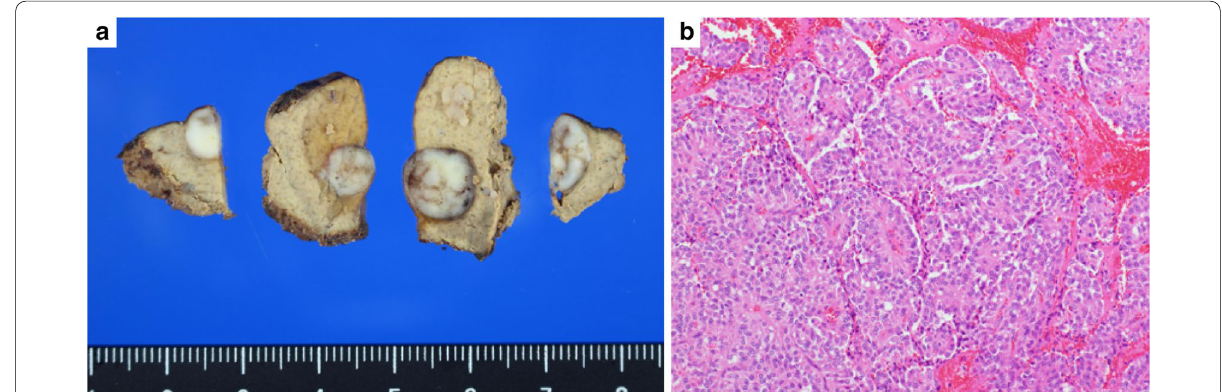
Fig. 4 Gross and histopathological findings of the excised specimens. Left image: gross tumor specimens. Right image: photomicrograph showing eosinophilic tumor cells proliferating throughout. The image shows a pseudopapillary structure centered on a thin vascular connection network. These findings are similar to the previous